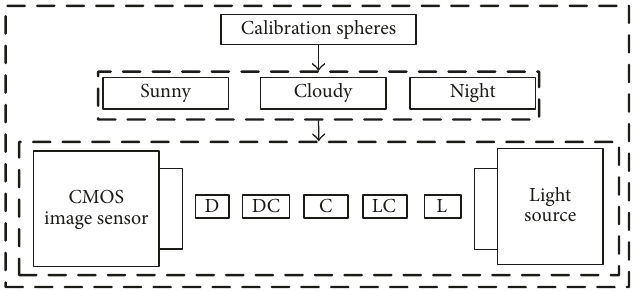
Figure 9: Flowchart of the calibration